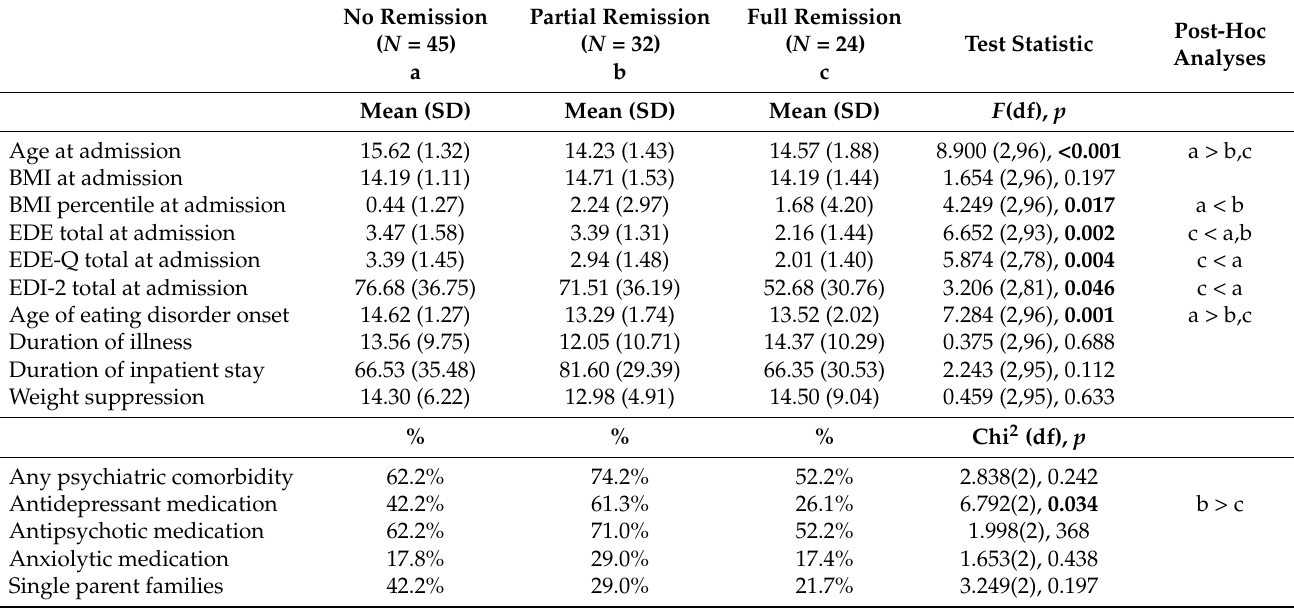
Table 3. Differences between remission groups regarding demographic and clinical